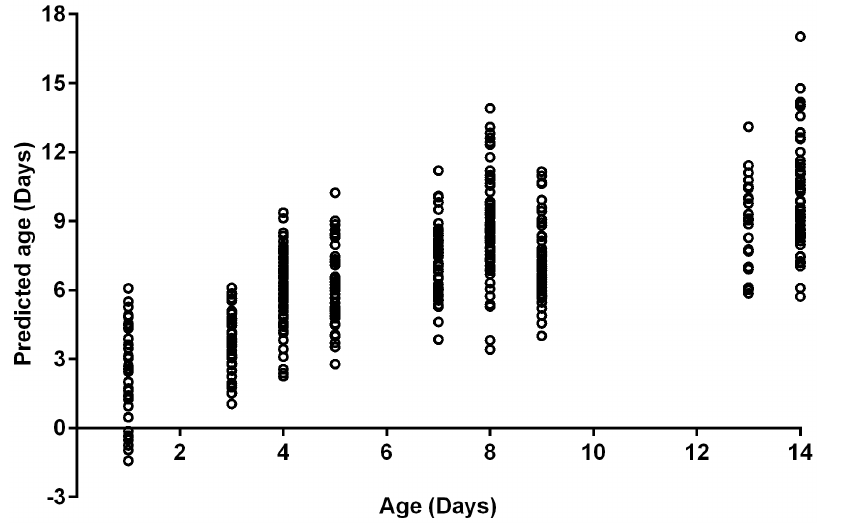
Figure 1. NIRS age prediction of individual female laboratory-reared Anopheles spp. The specimens include mosquitoes that were tested using the WHO resistance assay at 3, 7 and 12 d post emergence and sampled one day post pesticide exposure and unexposed mosquitoes sampled at 1, 3, 5, 7, 9 and 14 d post emergence.